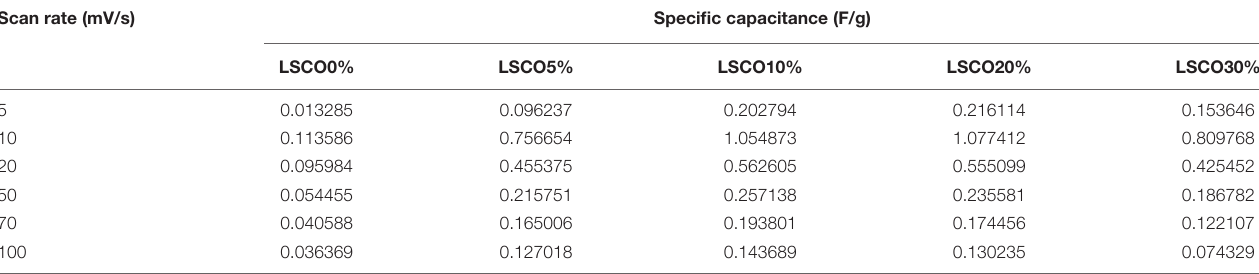
TABLE 1 | Calculated specific capacitance of the LSCO0%, LSCO5%, LSCO10%, LSCO20%, and LSCO30% samples at scan rates of 5, 10, 20, 50, 70, and 100 mV/s. Scan rate (mV/s)